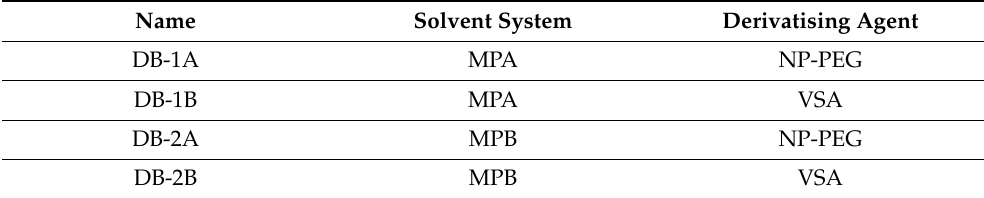
Table 2. Conditions used in performing the HPTLC